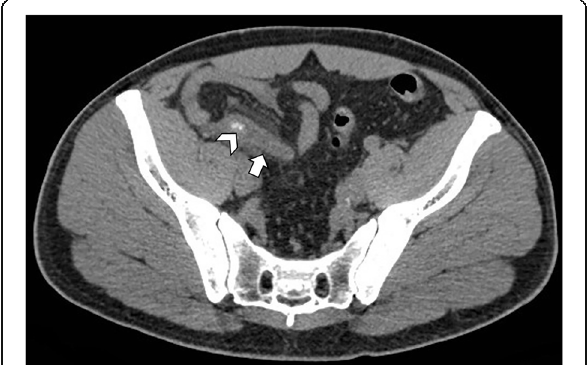
Fig. 12 Acute appendicitis in a 43-year-old man. Axial non-contrast CT image shows an inflamed vermiform appendix (arrow), with thickened wall and nearby fat stranding. Appendicoliths are identified within the appendix (arrowhead)